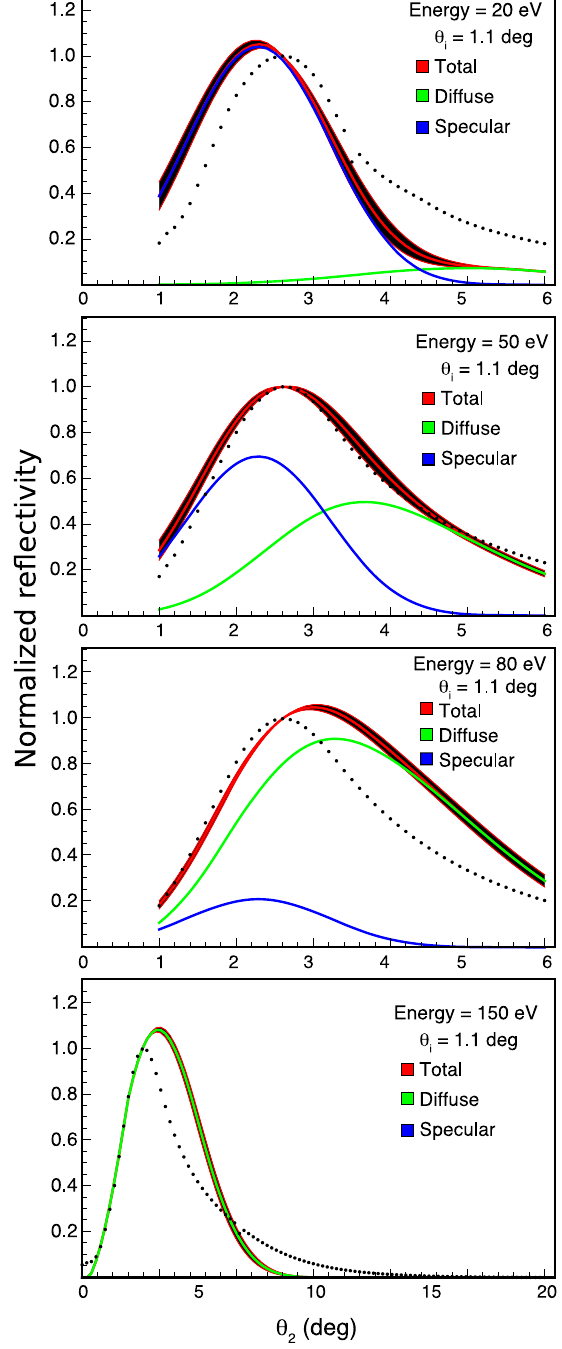
FIG. 25. Data sets Th1-Th4: Comparison between measure- ment and X-ray scattering model, θ 2 scans, for θ 1 ¼ 1 . 5 ° and various energies. The gray band represents the mean-prediction 95% confidence level associated with the fit. The relationship between θ and θ 1 is given in Sec. i